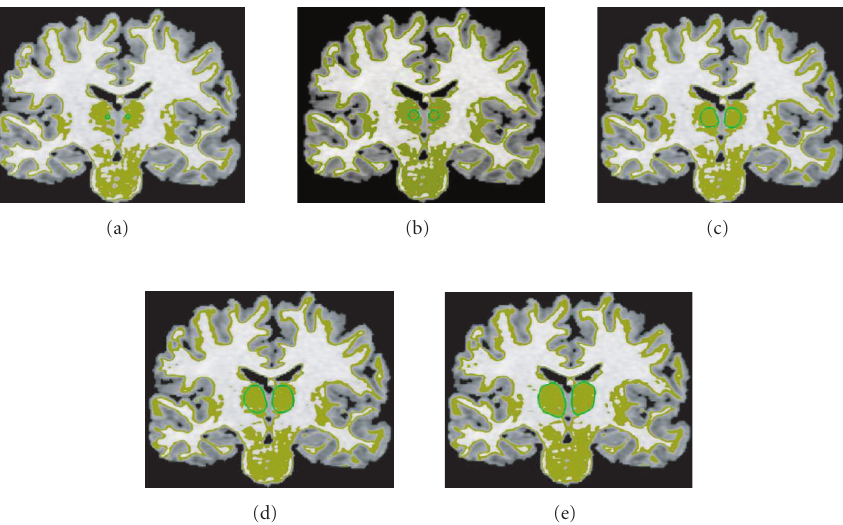
Figure 2: The same five snapshots of the model evolution process of the 2D thalamus segmentation superimposed with the binary mask created by interior statistics estimation.